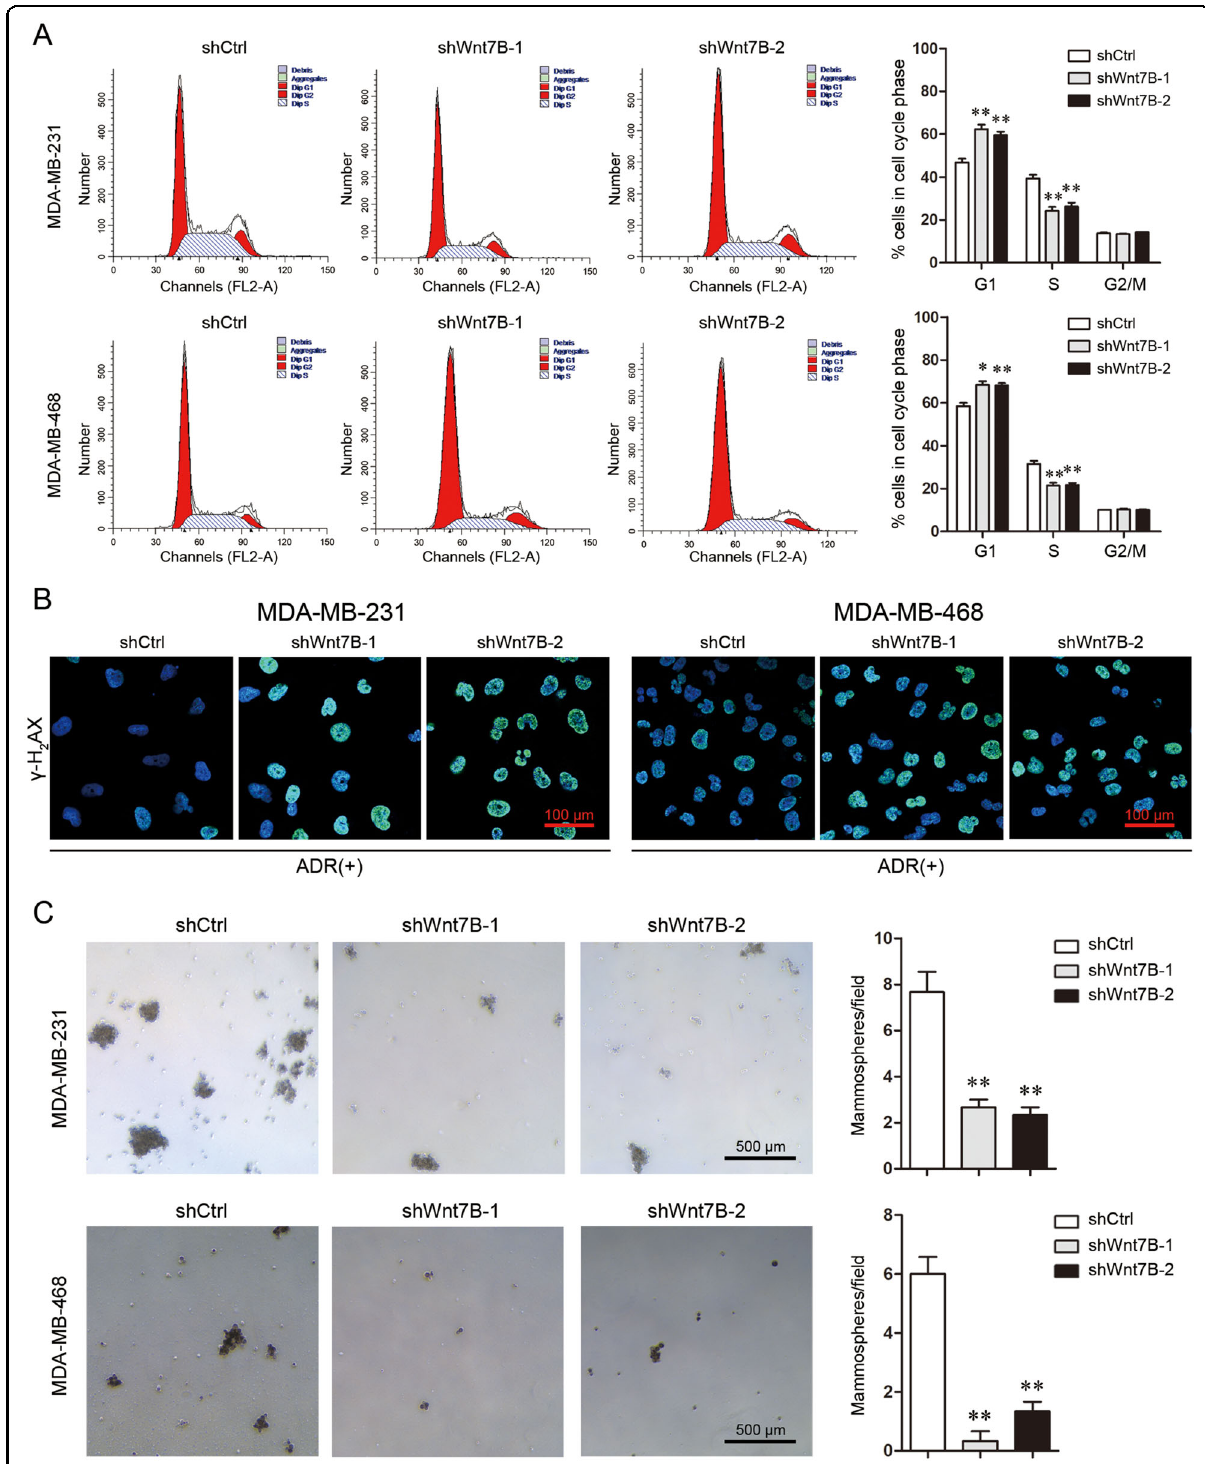
Fig. 8 Wnt7B is involved in cell proliferation, DNA damage repair, and stemness. A Cell cycle of MDA-MB-231 and MDA-MB-468 cells was analyzed by fl ow cytometry. B γ -H2AX expression in MDA-MB-231 and MDA-MB-468 cells was detected by immuno fl uorescence 48 h after treatment with ADR (300 nM). Scale bar: 100 μ m. C Mammosphere formation of MDA-MB-231 and MDA-MB-468 cells was shown. Scale bar: 500 μ m, mean ± SD, n = 3. * P < 0.05, ** P < 0.01, vs.